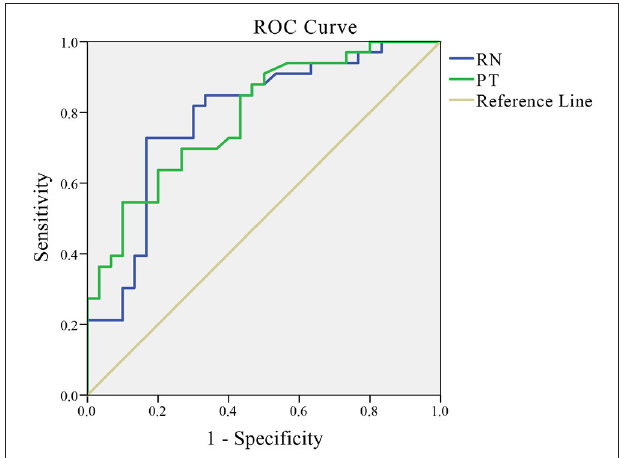
FIGURE 3 | ROC curves of QSM values in RN and